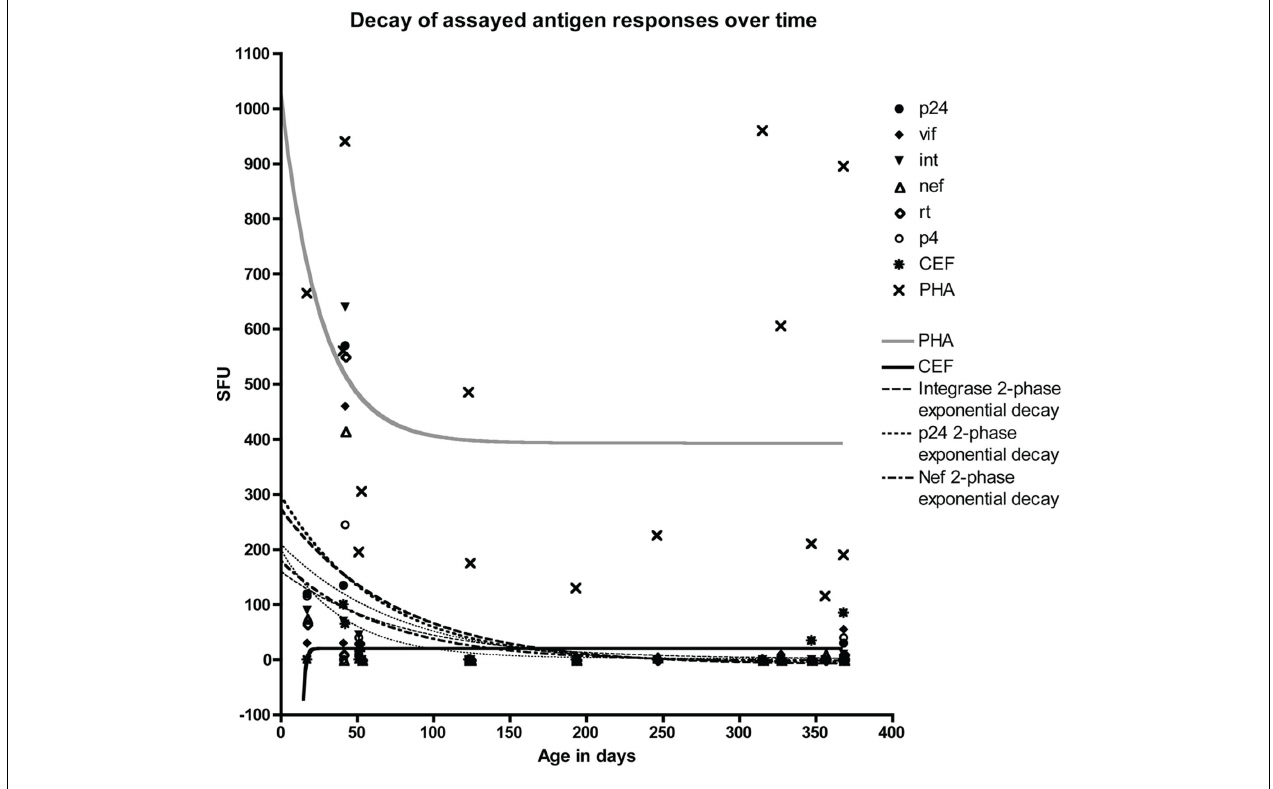
between 0 and 100days of age, with non-convergent two-phase exponential decays for Gag p24, Int, and Nef (half-lives observed were 163.3, 236.7, and 161.4days